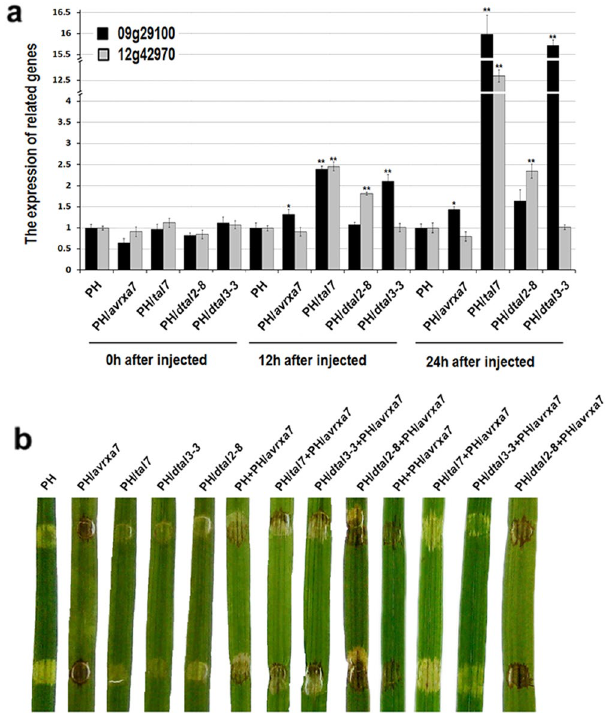
Figure 5. Os09g29100 is a major susceptibility gene in rice that can mask or suppress AvrXa7-Xa7 ETI. Strain PH, a tal-free strain of Xoo (Supplemental Table S1) was used in these experiments. ( a ) Expression of rice genes Os09g29100 and Os12g42970 in planta by real-time qRT-PCR. Xoo strain PH, PH/avrXa7, PH/tal7, PH/ dtal3-3 and PH/dtal2-8 were infiltrated into IR24 rice leaves, and expression of Os09g29100 and Os12g42970 was evaluated 0, 12 and 24 hpi. Data are the mean ± SD of triplicate measurements from a representative experiment, and similar results were obtained in two other independent experiments. The asterisks in each column indicate significant differences at P = 0.01 by t test. ( b ) Role of Tal7 and two dTALEs in suppressing avrXa7 - Xa7 ETI. Xoo strain PH and PH harboring avrXa7 , tal7 , dtal3-3 or dtal2-8 were infiltrated into rice seedlings of IRBB7 ( Xa7 ) with needleless syringes. Images show inoculation with a single strain (five panels on left), one strain followed 3 h later with another strain (four middle panels), and two co-infiltrated strains (four panels at right). Leaves were scored for water-soaked symptoms or the HR within the infiltrated area 3 dpi and were designated as susceptible or resistant (showing an HR). Leaves were photographed 3